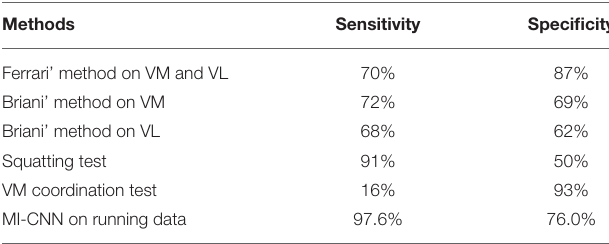
TABLE 4 | Comparison results with previous methods. Methods Sensitivity